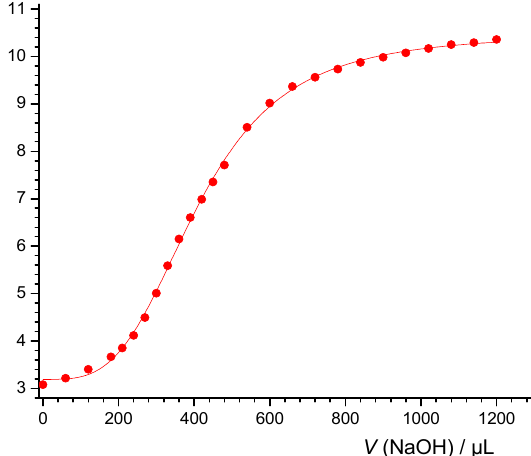
Figure A3. Fit of applied logistic function with experimentally obtained data of acid–base titration of CNT suspension in aqueous NaCl solution.